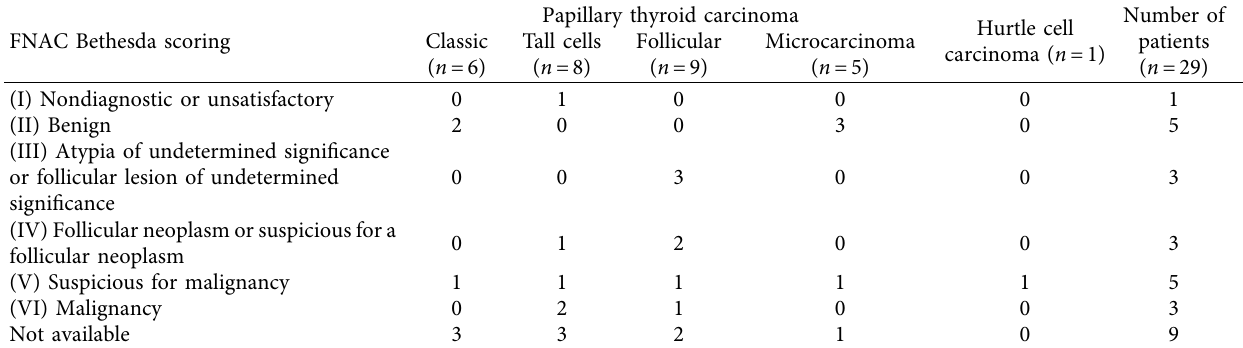
Figure 1: (a). A case of PTC showing follicular structures (H&E staining: 400x). (b). The tumor cells were overlapped and showed typical ground glass nuclei (H&E staining: 400x). (c). A case of tall cells variant of PTC, the tumor cells showed a height of 2–3 times the width and abundant eosinophilic cytoplasm (H&E staining: 400x). (d). A case of Hurthle cell carcinoma (H&E staining: Table 2: FNAC Bethesda scoring details.